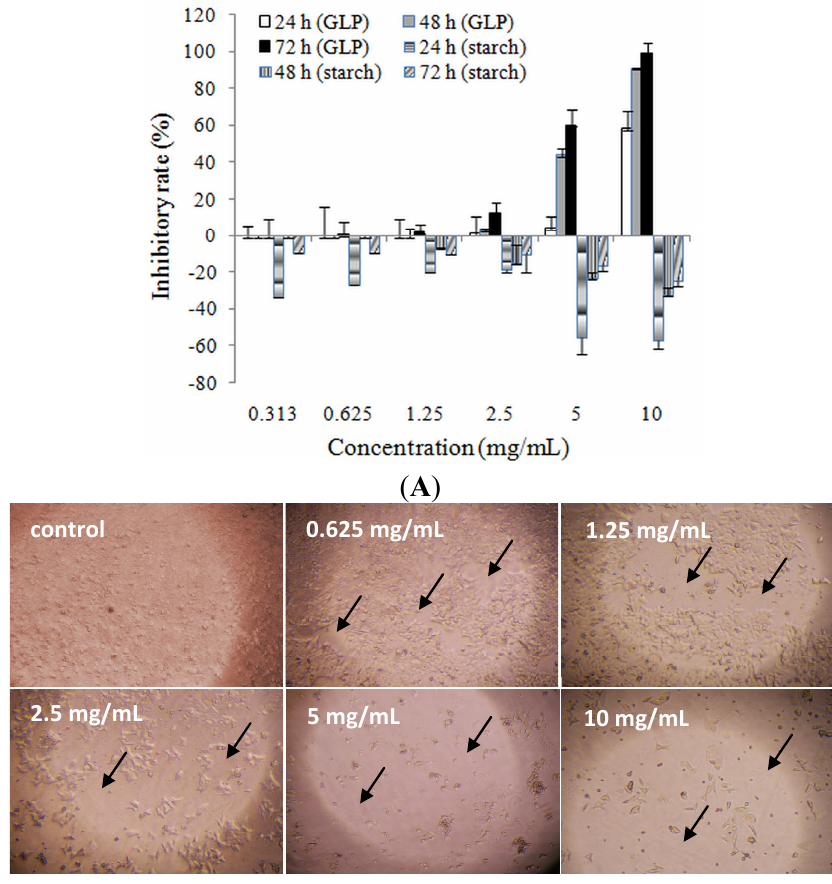
Figure 3. Cytotoxicity of GLP on HCT-116 cells: ( A ) GLP suppressed the cell viability of HCT-116. Inhibitory rate was measured by MTT method. Starch-incubated cells were applied as control. Data represent means ± SD of three independent experiments; and ( B ) Morphological changes in HCT-116 cells. After treatment with GLP, exfoliation of HCT-116 cells and naked areas were observed and captured under an inverted microscope (×100). The arrows ( ↑ ) show naked areas without